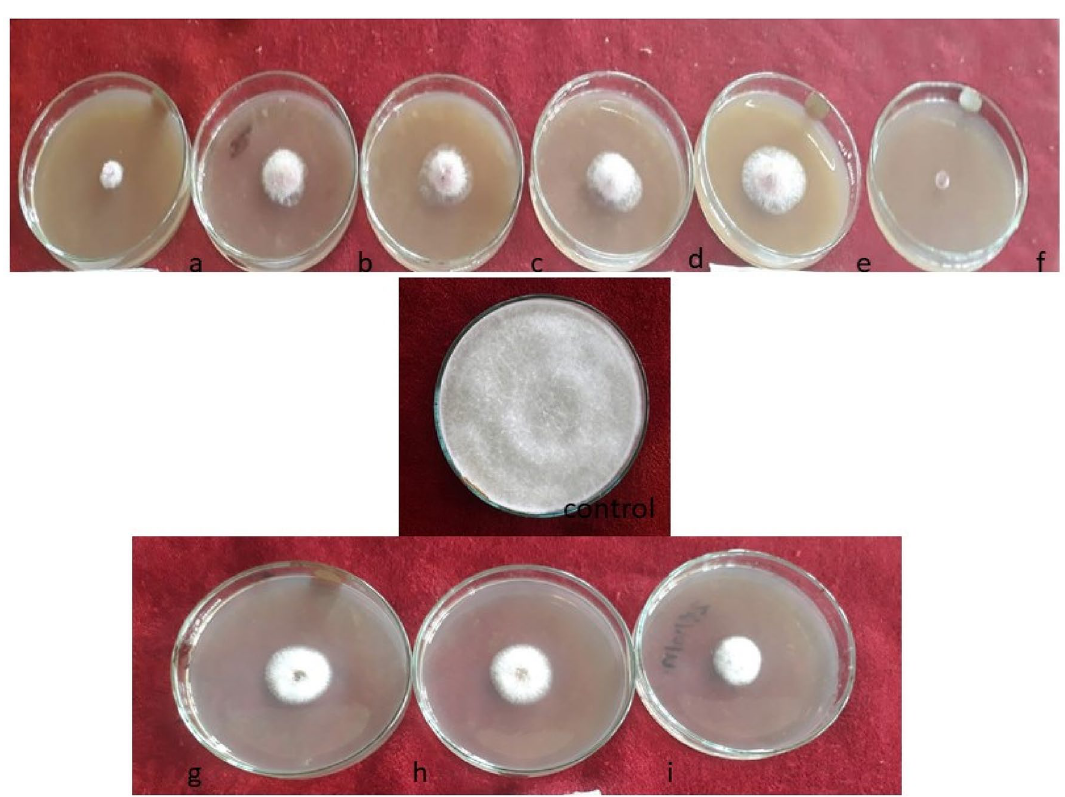
Figure 5. In vitro efficacy of fungicides against pathogen mycelial growth. ( a ) Captan50WP, ( b ) Tebuconazole 25EC, ( c ) Mancozeb 75WP, ( d ) Hexaconazole 75EC, ( e ) Metalaxyl 72WP, ( f ) Carbendazim 50WP, ( g ) Metiram + pyraclostrobin 60WG, ( h ) Difenconazole25EC, ( i ) Kresoximmethyl 44.3